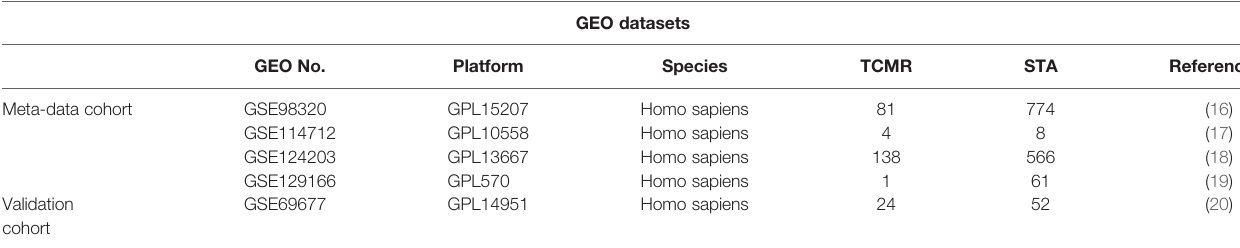
TABLE 1 | Basic information of the microarray datasets from